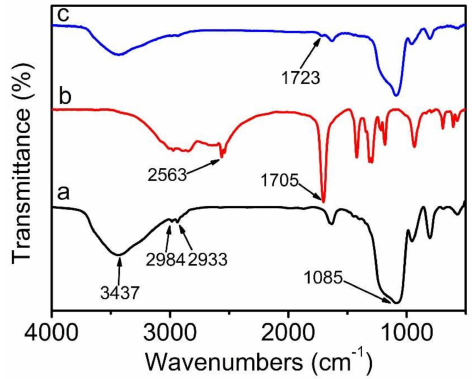
Figure 3. FTIR spectra of MSNs-SH ( a ), DMSA ( b ), and MSNs-SS-DMSA ( c